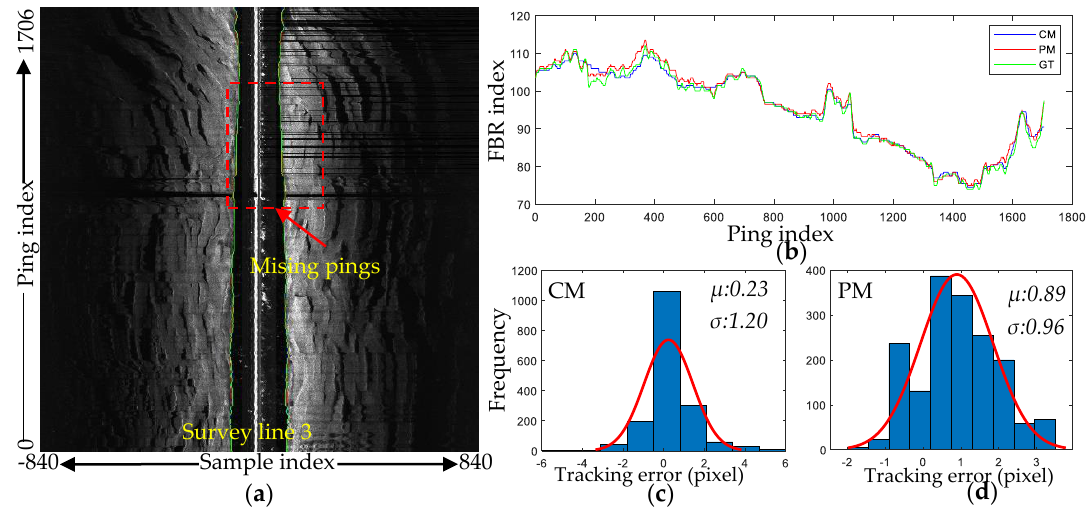
Figure 14. Bottom tracking experiment on the SSS data with missing pings. ( a ) Waterfall image re-quantized from raw SSS data. ( b ) Averaged bottom tracking results of port and starboard with the tow methods. ( c , d ) Error distribution relative to the manual interpretation.